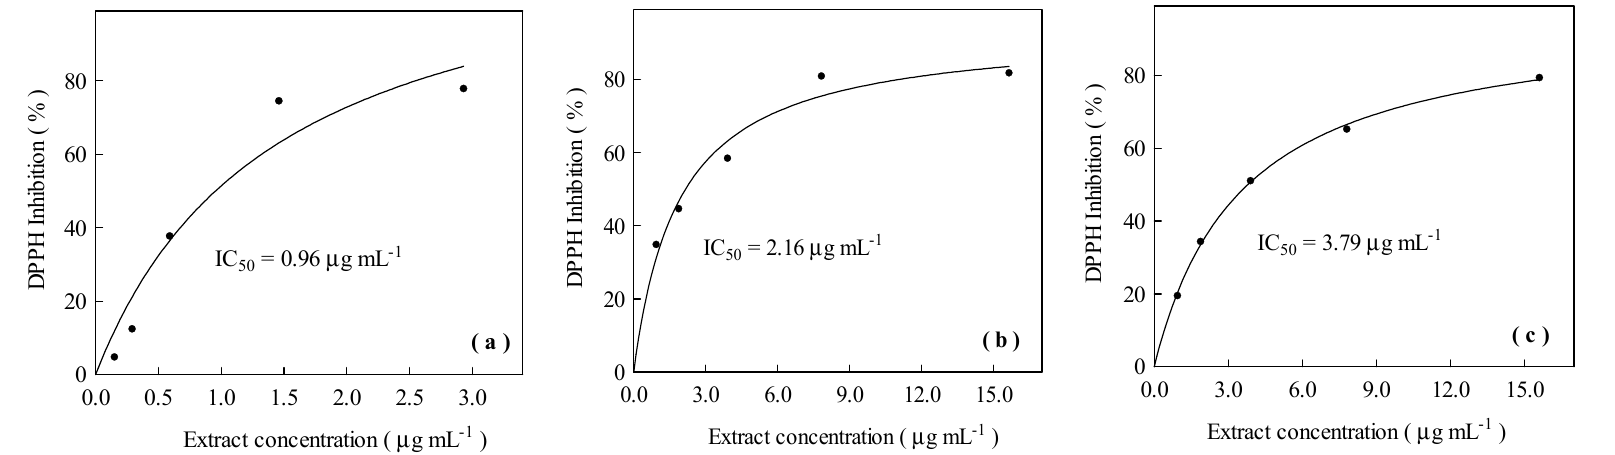
Figure 4. Experimental results of the DPPH • inhibition produced by the concentrated extract ( a ), spouted bed dried extract ( b ), and lyophilized extract ( c ).